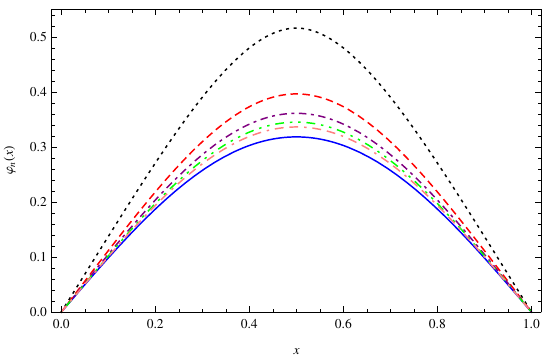
Figure 4: The exact solution u * ( x ) (solid line) and the matched n th- stage approximations φ n ( x ) for n = 2 (dot line), n = 3 (dashed line), n = 4 (dot-side line), n = 5 (dot-dot-side line), and n = 6 (dot-side-side line).